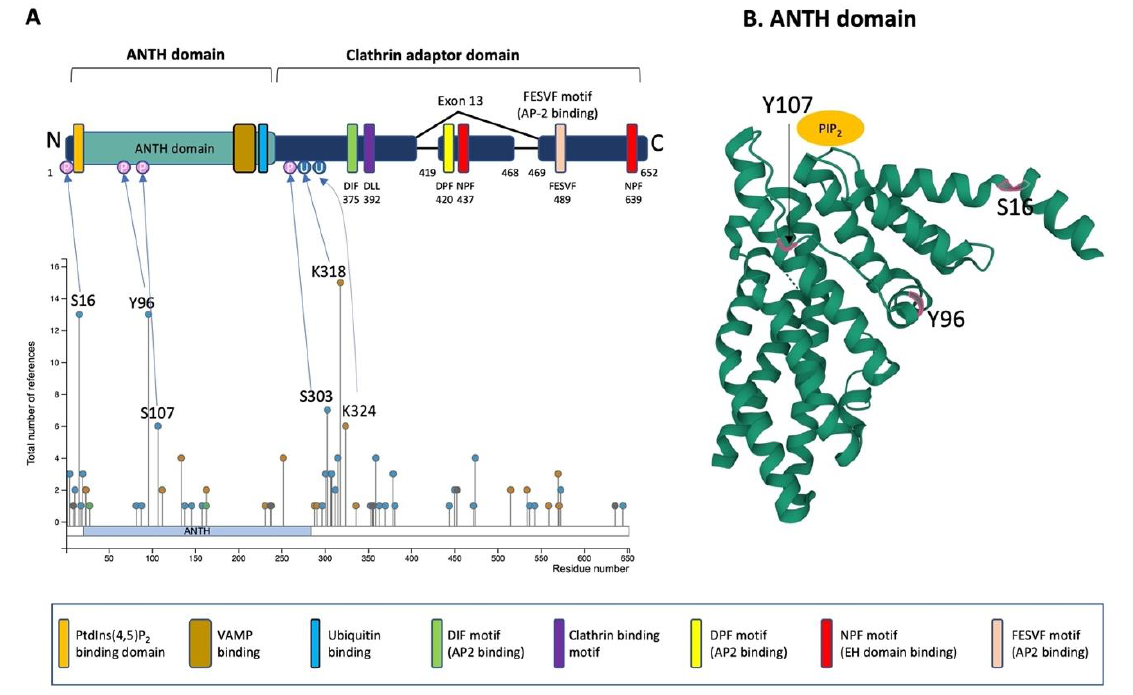
Figure 3. Schematic illustration of PICALM structure and post-translational modifications. ( A ) Schematic structure of PICALM. PICALM is constituted of two distinct domains: the ANTH (AP180 N-terminal homology) domain and clathrin adaptor domain. ANTH domain contains a PtdIns(4,5)P 2 binding domain and vesicle-associated membrane protein (VAMP) binding domain. Clathrin adap- tor domain contains several motifs that are critical to interact with endocytic protein, including DIF, DLL Clathrin binding, DPF, NPF and FESVF motifs. DIF motif binds to AP2. DLL motif is conserved